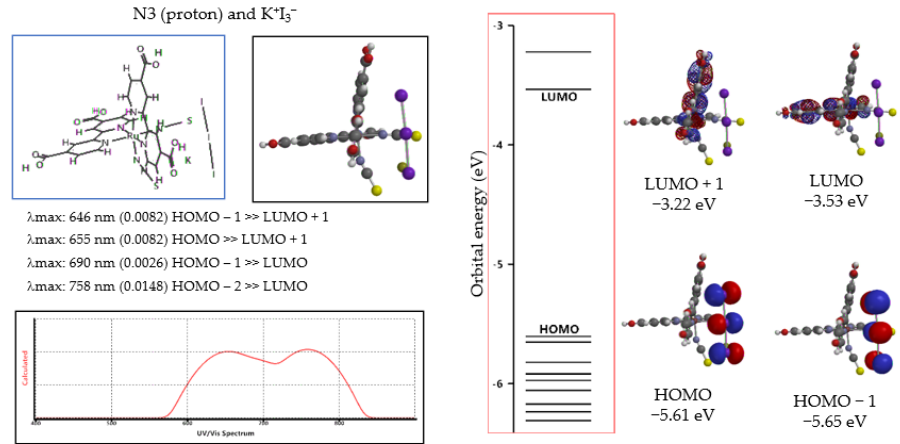
Figure 9. Van der Waals Aggregation of N3 with potassium triiodide to respective N3 and (KI 3 ) 2 and N3 and K + I 3− .